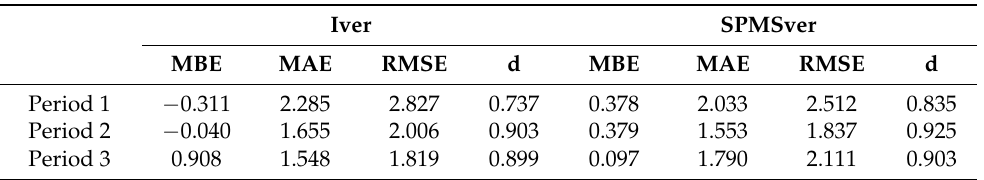
Table 3. Median values of MBE, MAE, RMSE and d for the Iver and SPMSver and the three meteorological periods regarding temperature ( ◦ K).